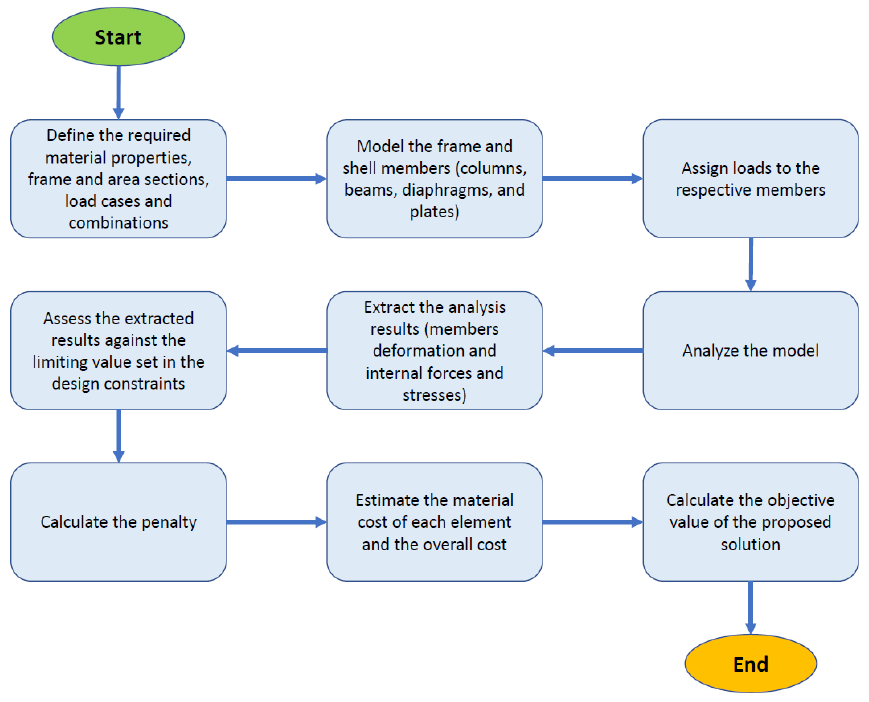
Figure 10. Flow chart for API and constraints in MATLAB.